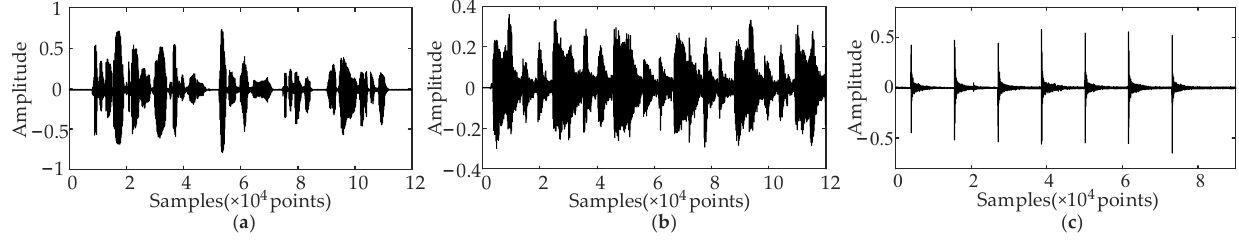
Figure 3. Audio signal for simulation: ( a ) speech; ( b ) music; ( c ) impulse noise.